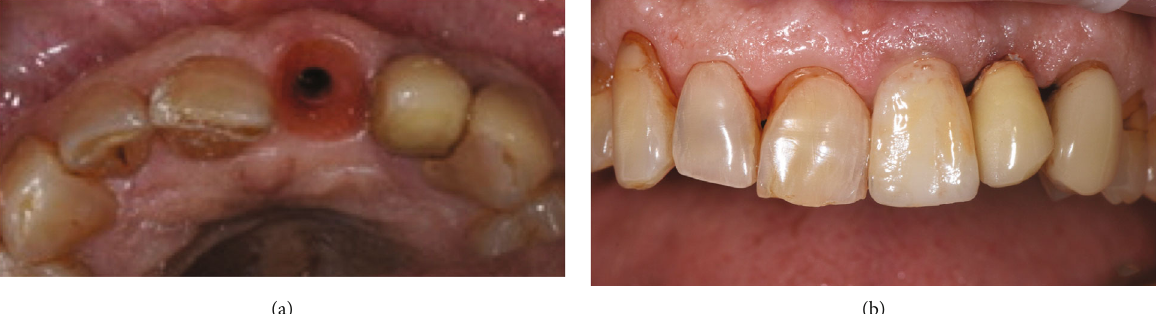
Figure 2: (a) Final tissue healing after 6-month follow-up. No signs of in fl ammation or rejection of the fragment were observed. (b) The fi nal de fi nitive restoration 5-year follow-up; the gingival tissues are healed and preserved.